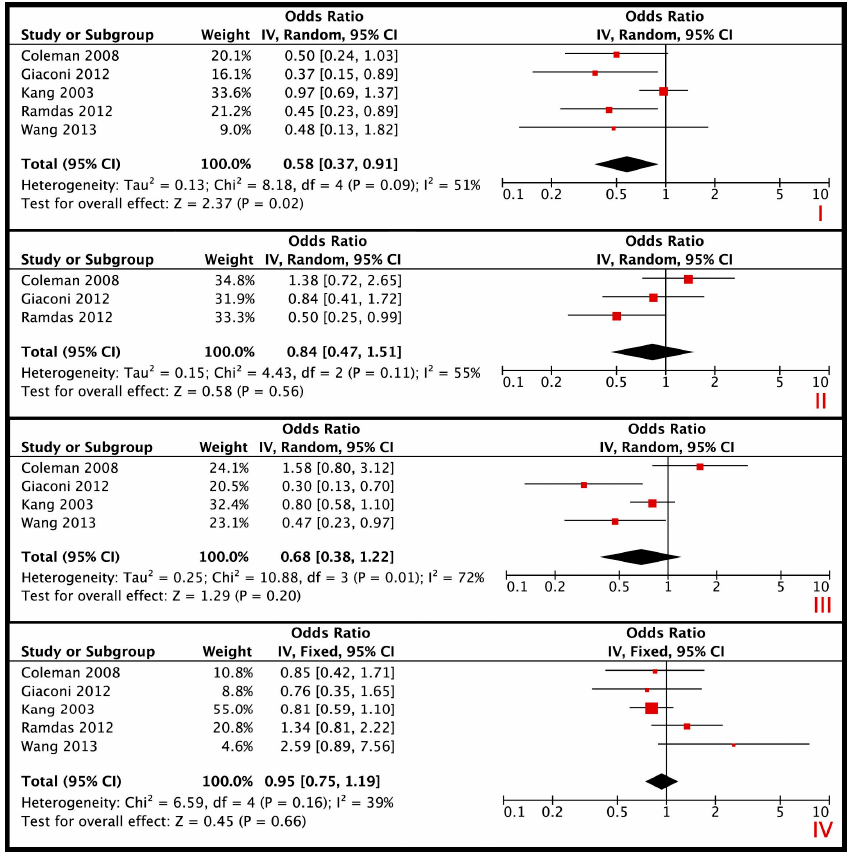
Figure 2. Meta-analyses for the association of vitamin A (I), B1 (II), C (III), and E (IV) with open-angle glaucoma. Black diamonds indicate the overall OR. The size of the red box is inversely proportional to the variance. Horizontal lines indicate 95% CI. The dashed vertical line in each panel shows the value for no effect (OR = 1.0).